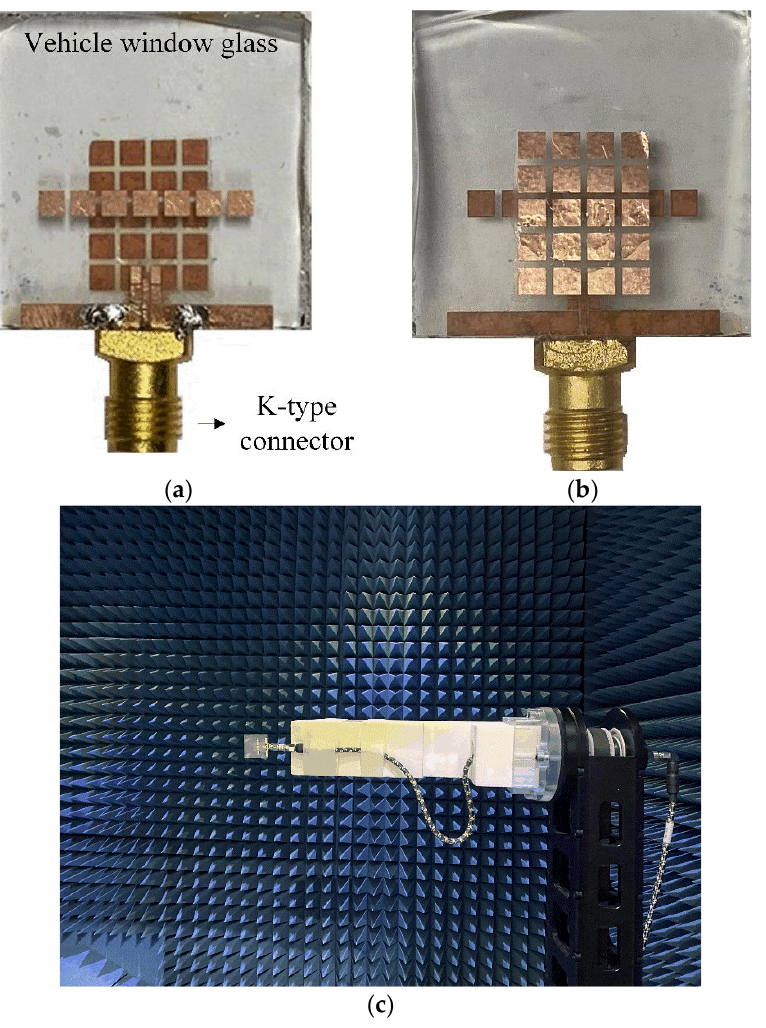
Figure 11. Photographs of the proposed antenna and measurement setup: ( a ) top view; ( b ) bottom view; ( c ) measurement setup.